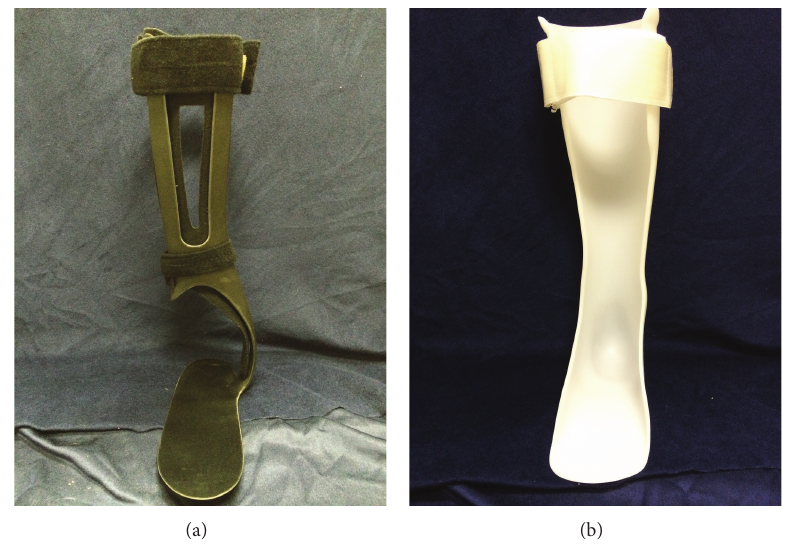
Figure 1: Off-the-shelf carbon AFO (a) and custom plastic AFO (b) used in the